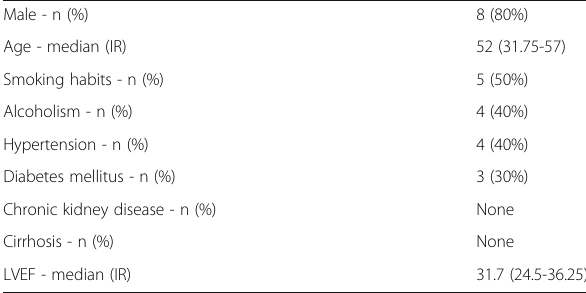
Table 1 (abstract 000917). See text for